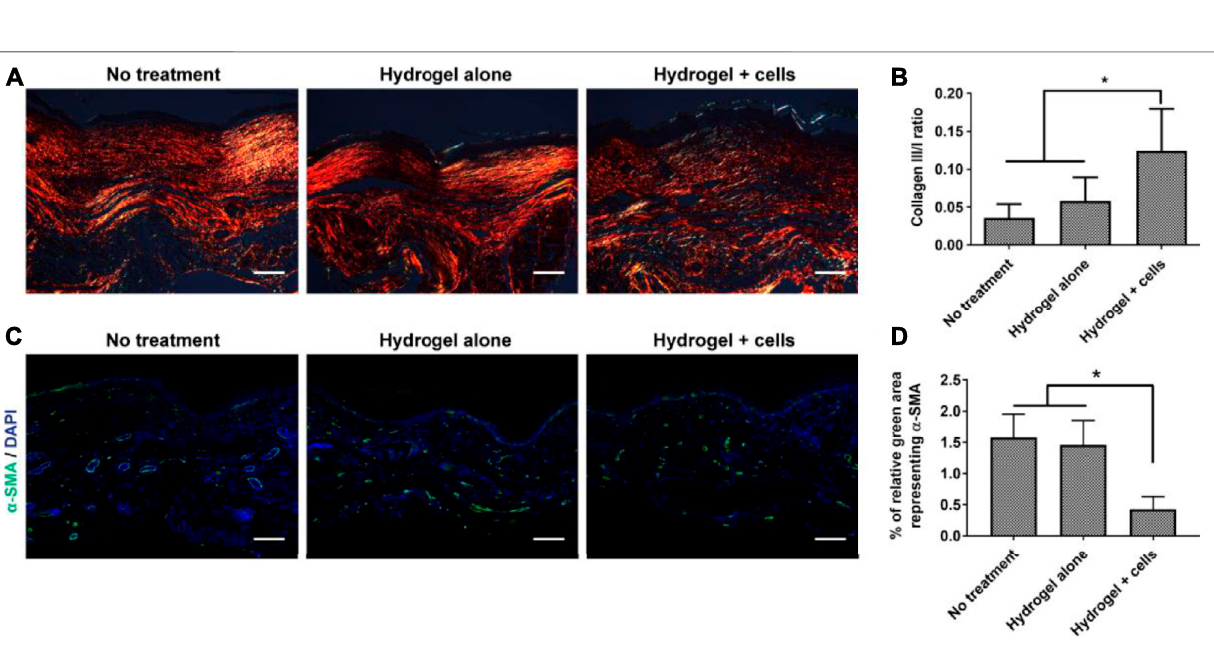
FIGURE 9 | Effects of the PEG-HA-RGD hydrogel-ASC treatment on tissue remodeling and scar formation. (A) Collagen deposition of the wounded area was assessedbypolarizedlightmicroscopywithpicrosiriusredstaining. (B) TheratioofcollagentypeIII/Iissigni fi cantlyhigherin “ hydrogel+cells ” treatmentcomparedtothe control groups. (C) Representative fl uorescent images of α -SMA + stained cells in healed wounds. (D) Quanti fi ed result demonstrates the hydrogel-ASC treatment signi fi cantly decreases representing α -SMA positive myo fi broblasts in healed wounds (Dong et al., 2020). Images were adapted with permission from Dong et